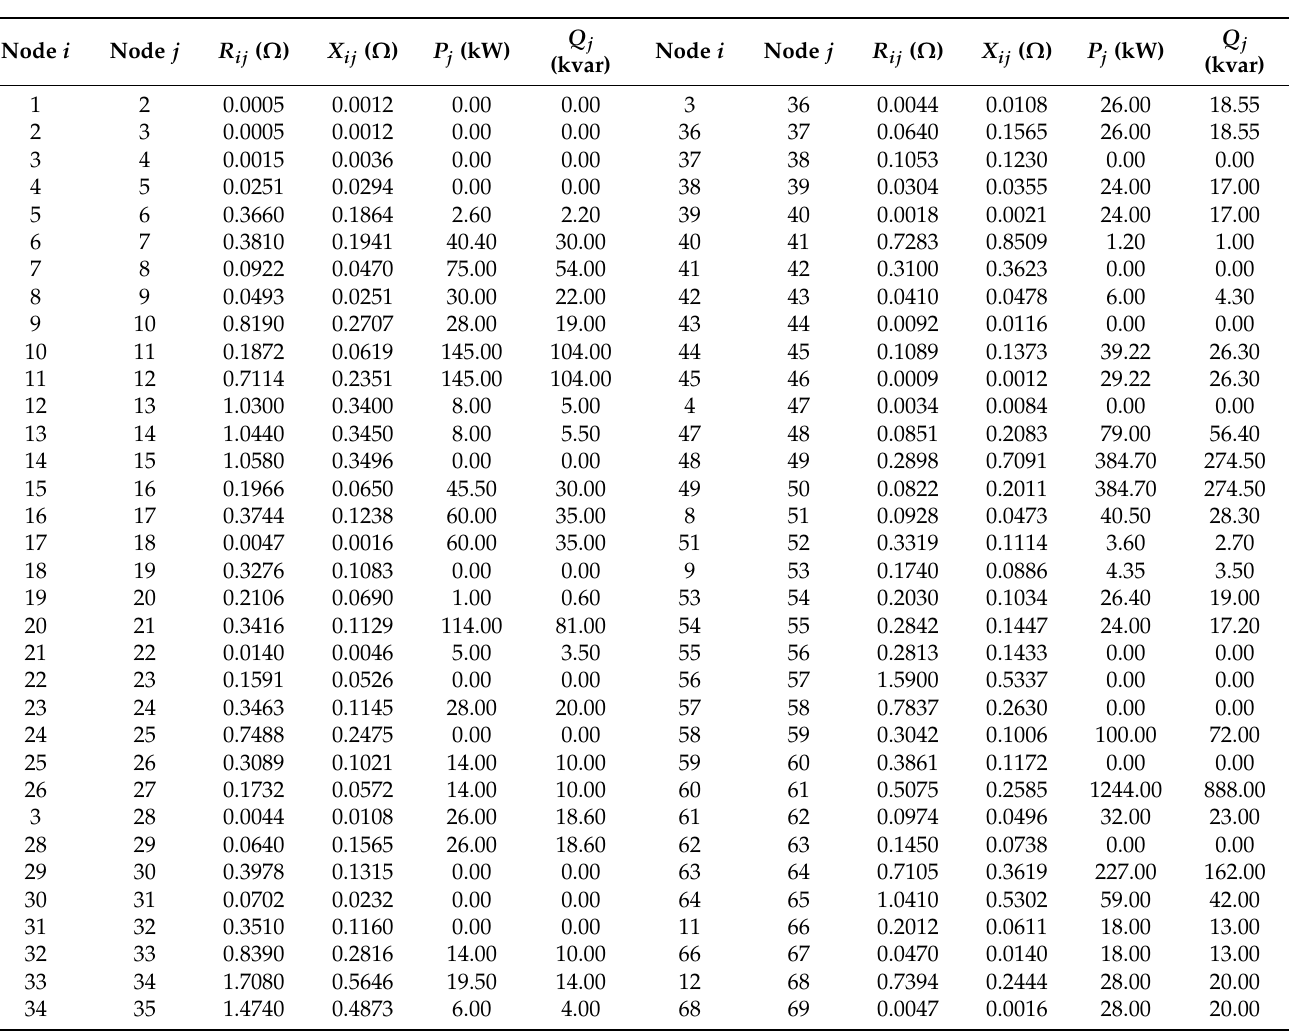
Table 3. IEEE 69-bus system